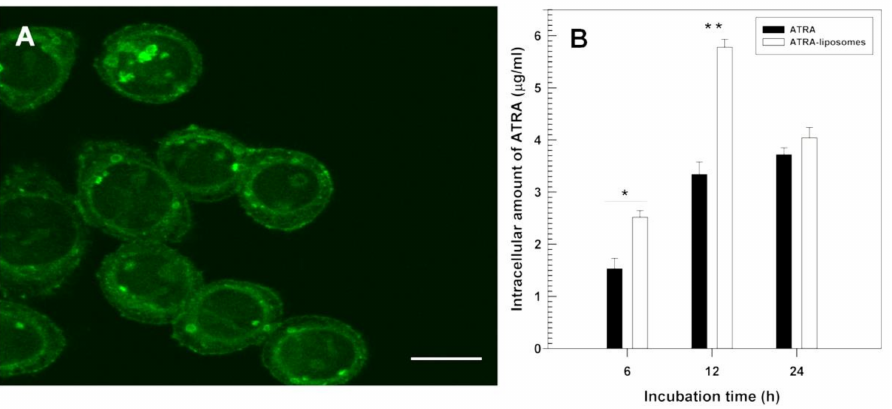
Figure 3. ( A ) Confocal laser scanning micrograph showing the interaction between fluorescein-labeled liposomes and FRO cells after 6 h incubation (bar = 35 µ m) and ( B ) intracellular uptake of ATRA as free form or entrapped in liposomes within FRO cells as a function of the incubation time. Reproduced with permission [16]. * p < 0.05, ** p <